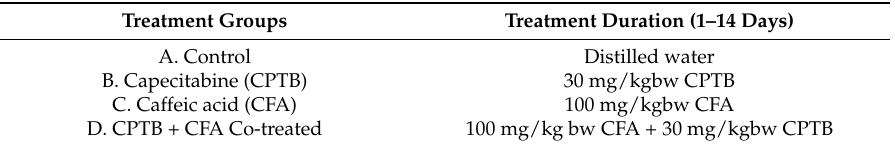
Table 1. Experimental